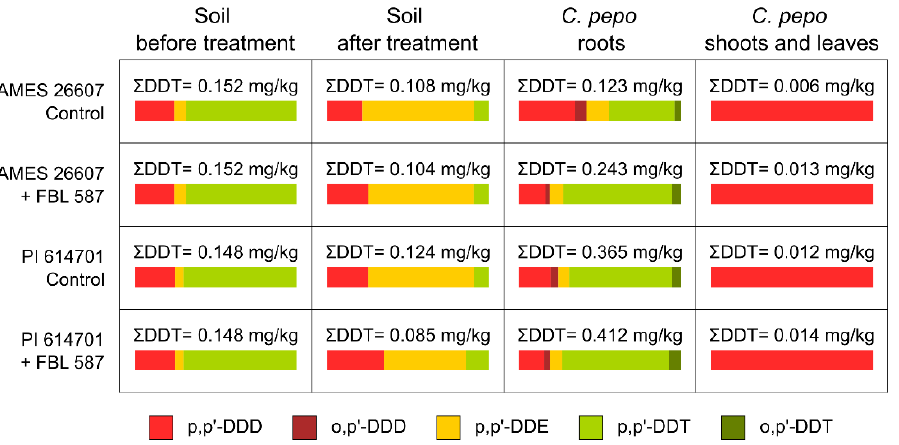
Figure 1. Effect of the soil inoculation with T. hamatum FBL 587 on the DDT degradation in soil and phytoremediation capacity of two C. pepo accessions. The percentage of each DDT metabolite or residue detected in each fraction and treatment are represented by color bars. The total concentration of DDT metabolites and isomers ( Σ DDT) is indicated for each treatment.